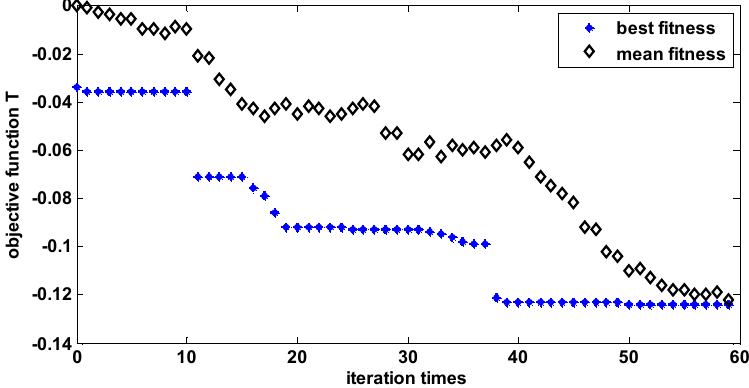
Figure 7. Best fitness and mean fitness vs . iteration times.